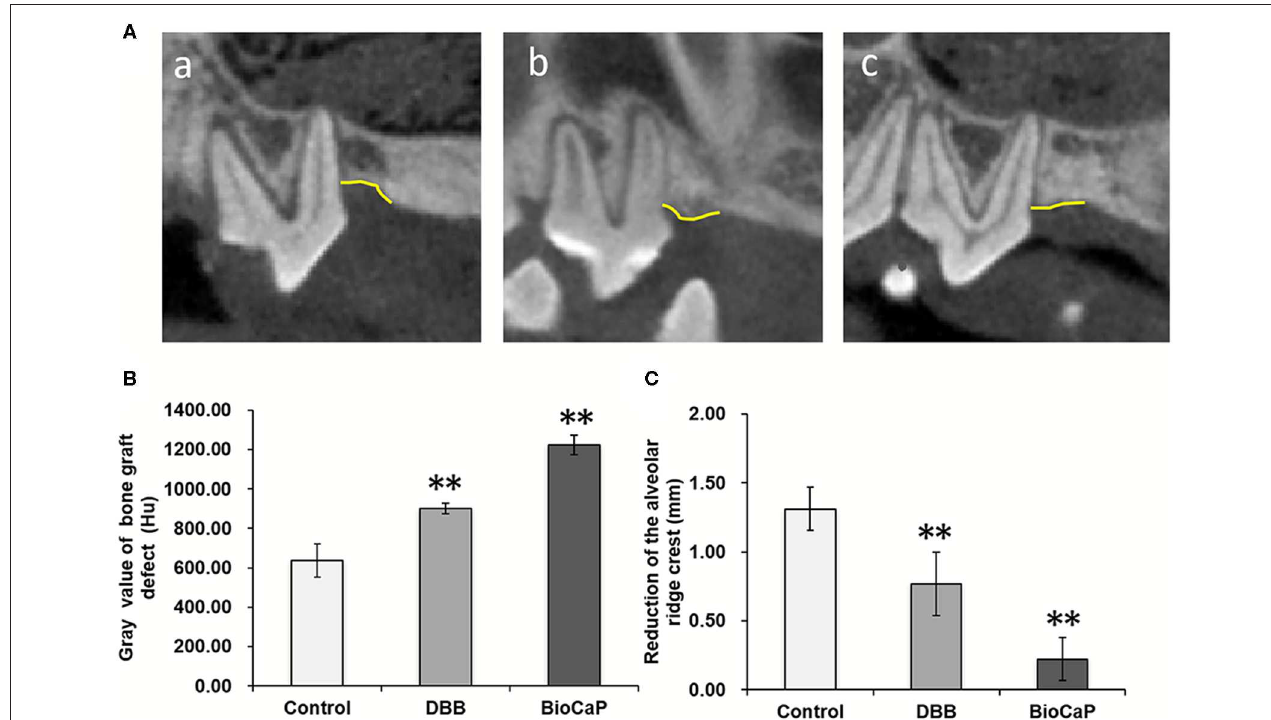
FIGURE 4 | (A) Representative CBCT images at week 8, (a) Control, (b) DBB, and (c) Bio-CaP group. (B) Gray value of bone graft defect (Hu). (C) Reduction of the alveolar ridge crest (mm). Data are presented as mean ± SD, from six independent experiments. Significant effect of the treatment, ** p < 0.01. Yellow line, alveolar bone ridge.